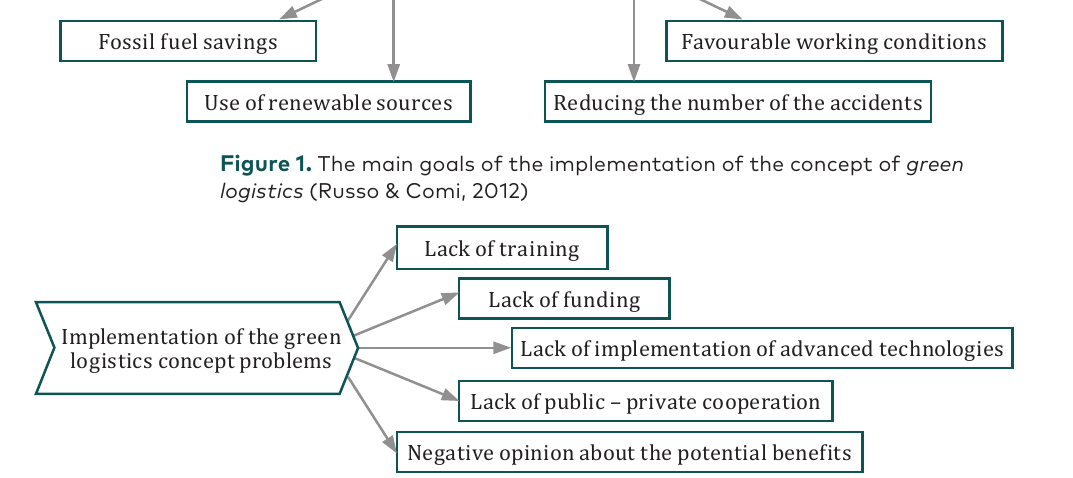
Figure 2. The main problem areas for implementing the concept of green logistics (created by the